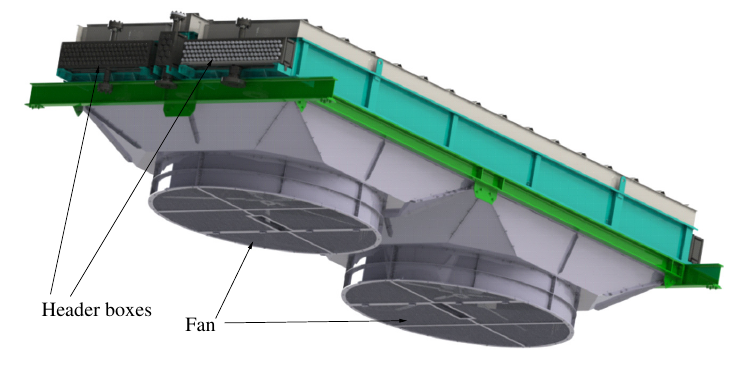
Figure 2. Part of an air-cooled heat